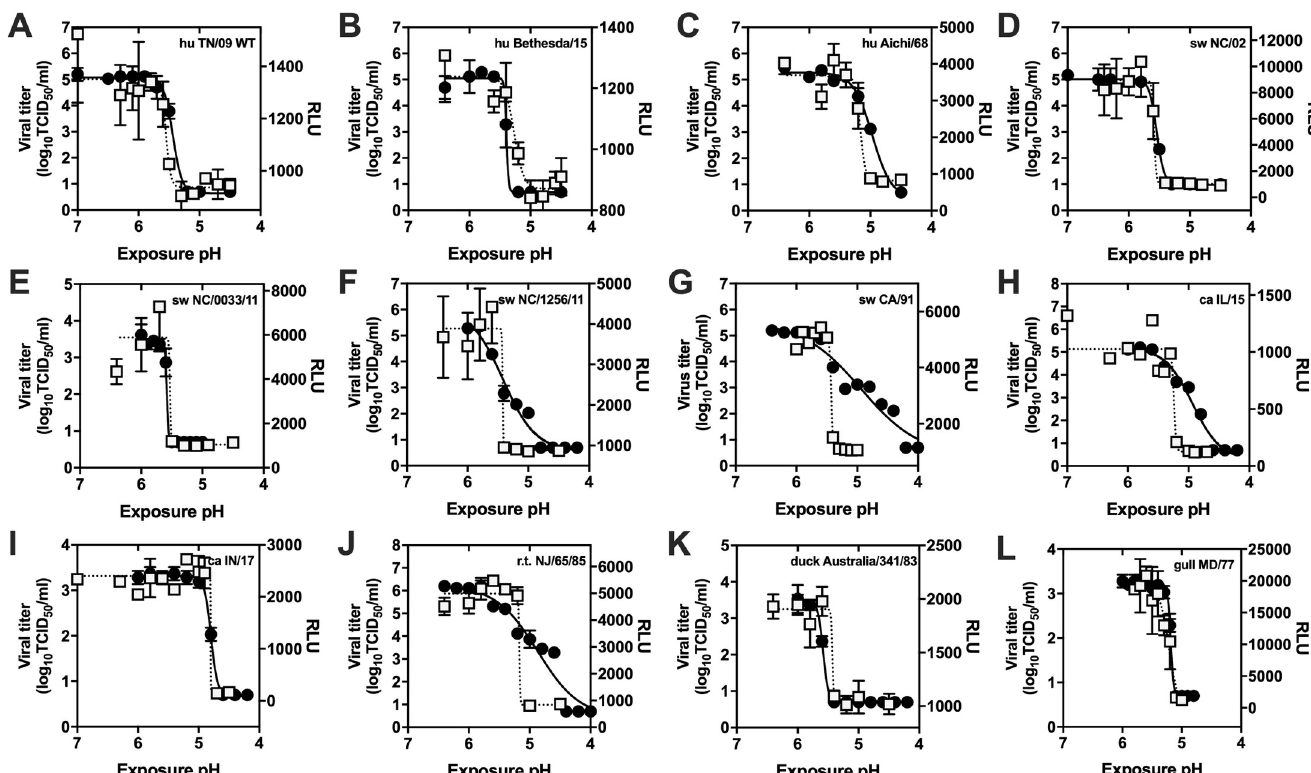
Fig 3. Virus inactivation measured by TCID50 and luciferase assays. TCID50 values (left y-axis, black circles) and luciferase activity (RLU, right y-axis, white squares) were measured as a function of exposure to the reported pH followed by re-neutralization. Right y-axes are scaled so that RLU maxima and minima are displayed at levels similar to those from TCID50 on the opposite axis. Error bars represent standard deviation (n = 3). Reported data are representative of two or more independent experiments. (A) rg-A/TN/1-560/2009 (H1N1). (B) A/Bethesda/55/2015 (H3N2). (C) A/Aichi/2/1968 (H3N2). (D) rg-A/swine/NC/18161/2002 (H1N1). (E) A/swine/North Carolina/0033/2011 (H3N2). (F) A/swine/North Carolina/1256/2011 (H3N2). (G) A/swine/California/T9001707/1991 (H1N1). (H) A/canine/ Illinois/41915/2015 (H3N2). (I) rg-A/canine/Indiana/1177-17-1/2017 (PR8 internal genes) (H3N2). (J) A/ruddy turnstone/NJ/65/1985 (H7N3). (K) A/duck/Australia/ 341/1983 (H15N8). (L) A/gull/Maryland/704/1977